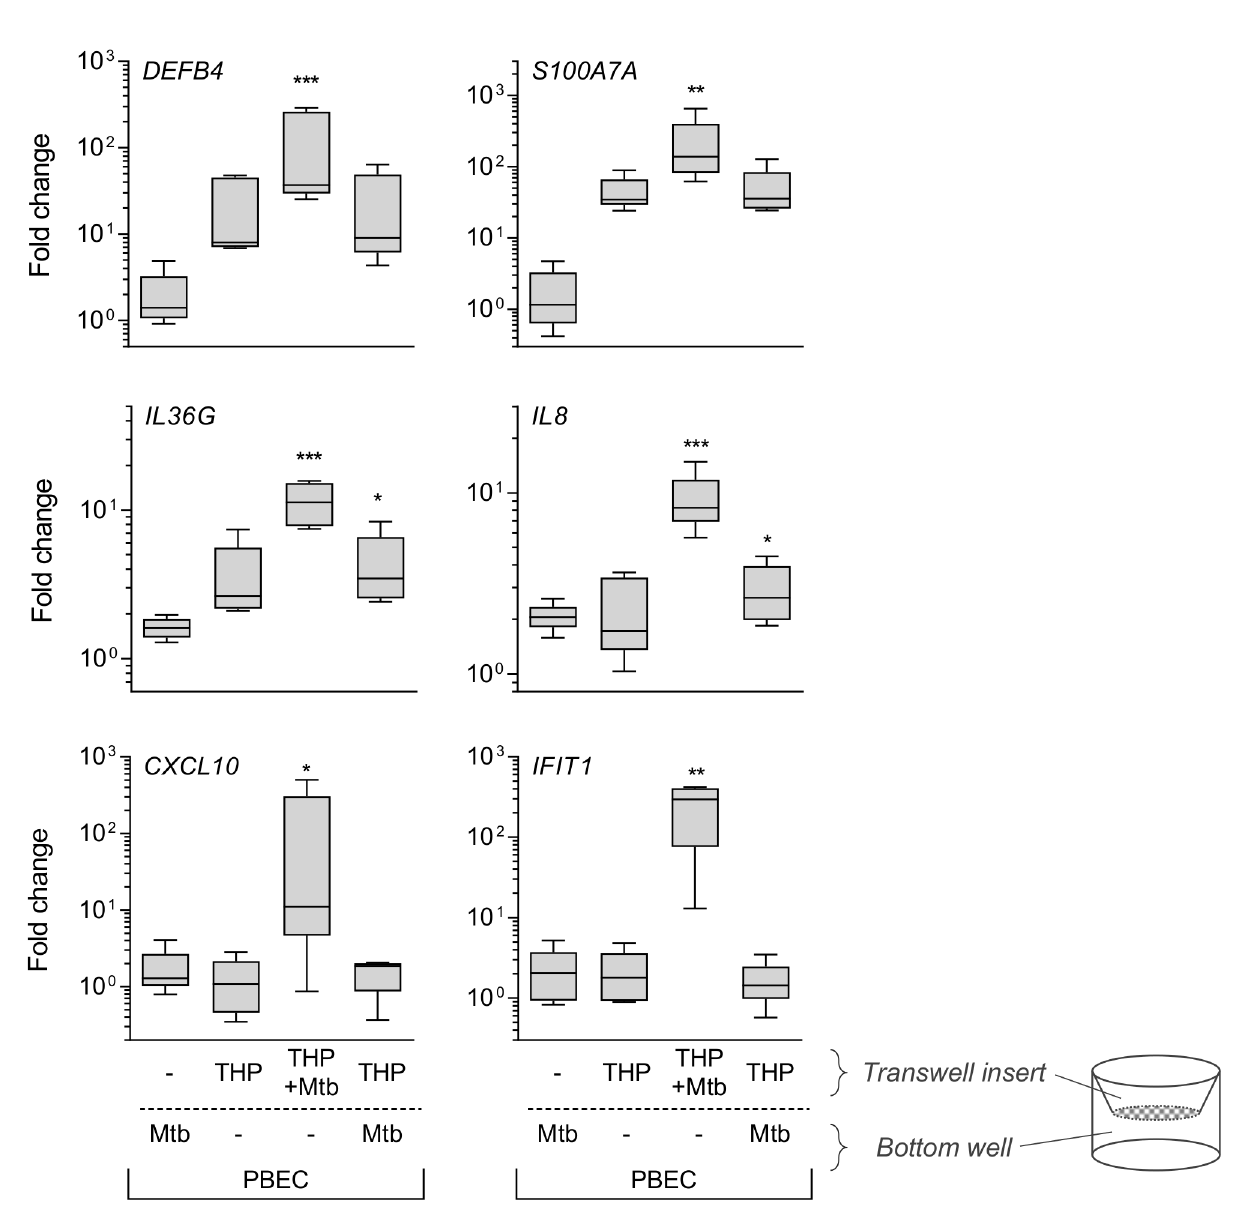
Fig 3. PBEC gene expressionin response to infection-driven inflammation is dependent on direct interaction between myeloid cells and Mtb. In the transwellmodel, PBECs were exposedto THP-1 cells or Mtb H37Rv bacilli(MOI5) for 24h as indicated. Gene expressionin PBECs was measuredby RT-PCR and is shownas fold changeover unstimulated PBECs (n = 5). Friedmantest with Dunn’s post-test was used to compareexpressionwith unstimulated controls (fold change = 1, not displayed). Boxplots show median and range. * p < 0.05; ** , p < 0.01; *** , p < 0.001; **** , p <